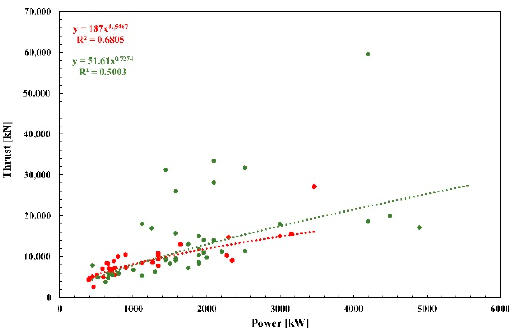
Figure 6. Correlation between the power supplied to the excavation head and the thrust. Red: open TBM; blue: single shield TBM; green: double shield TBM.